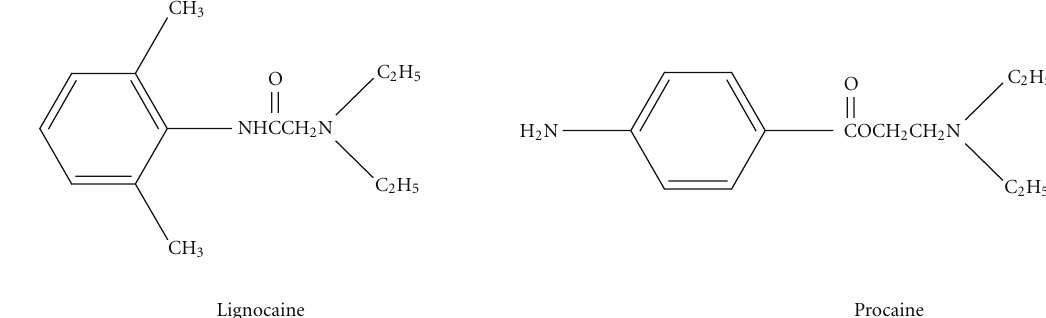
Figure 3: Amide local anaesthetic (lignocaine) and ester local anaesthetic (procaine).